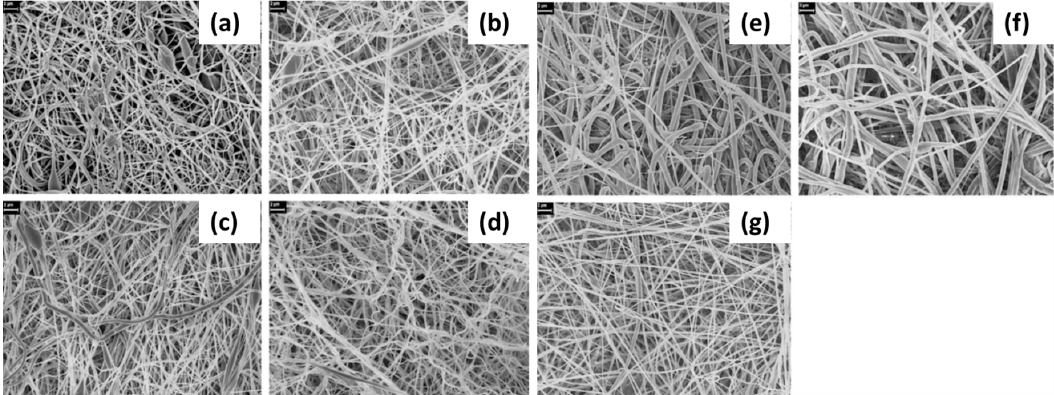
Figure 13. SEM images of electrospun composite nanofibers of PVDF/nanoclay with different nanoclay contents: ( a ) 0.0 wt.% (pure PVDF); ( b ) 0.2 wt.% STN; ( c ) 1.0 wt.% STN; ( d ) 5.0 wt.% STN;